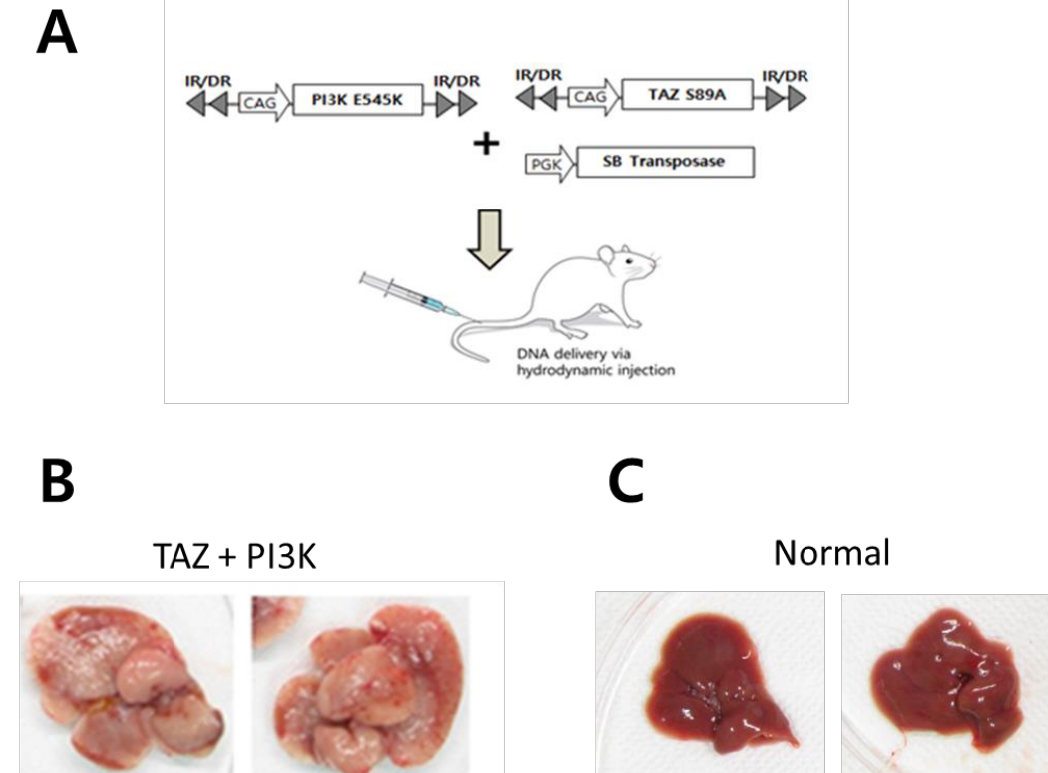
Figure 4. PI3K E545K and TAZ S89A induces intrahepatic CCC. ( A ) Schematic illustration of hydrodynamic tail vein injection (HTVI). ( B ) The gross morphology of representative livers expressing PI3K E545K and TAZ S89A . Livers were harvested at 6 weeks following HTVI. ( C ) The gross morphology of normal livers.